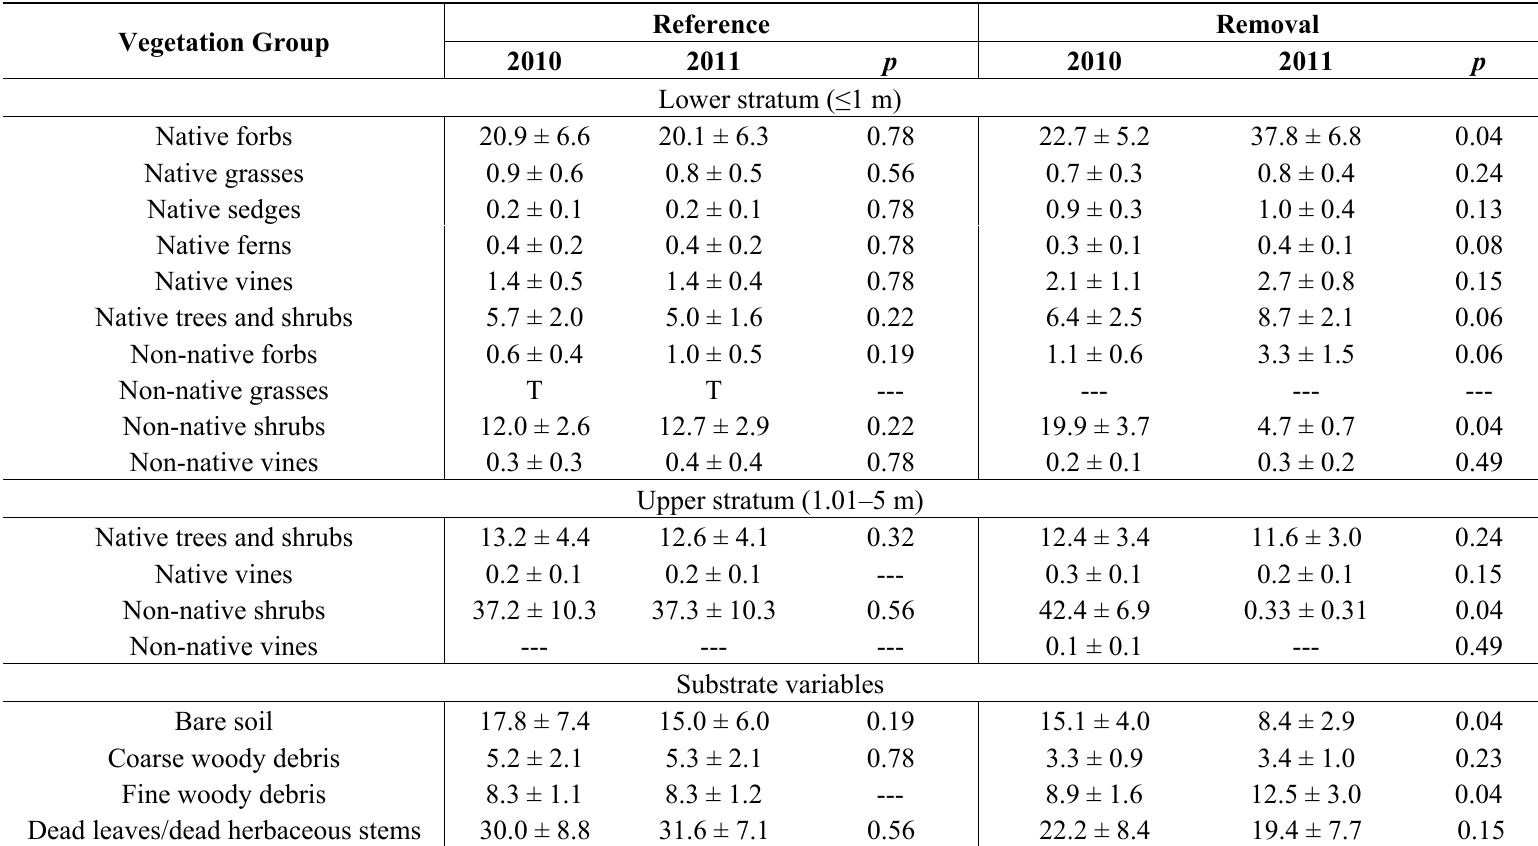
Table 3. Mean percent cover (±1 SE) and Wilcoxon signed rank test results for native and non-native plants (grouped according to growth habit) and substrate variables in reference and removal areas, during the summer seasons of 2010 and 2011 at six mixed-hardwood forests in central Indiana. Although mean values are presented, Wilcoxon p values were calculated to examine significance of differences between 2010 and 2011, based on ranks. For each group/substrate variable, mean values were calculated from the six study sites ( n = 6 for each species in a given treatment type, year, and season). Plant data were collected in the lower stratum ( ≤ 1 m) and upper stratum (1.01–5 m) whereas substrate data were collected only in the lower stratum. p -values were adjusted for multiple comparisons with a graphically-sharpened procedure to control the false discovery rate [35]. Adjustments were made separately for reference and removal areas. T = trace (<0.1%